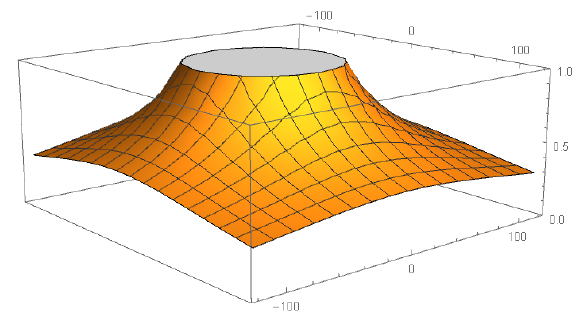
Figure 1. Stability region of z = 1.